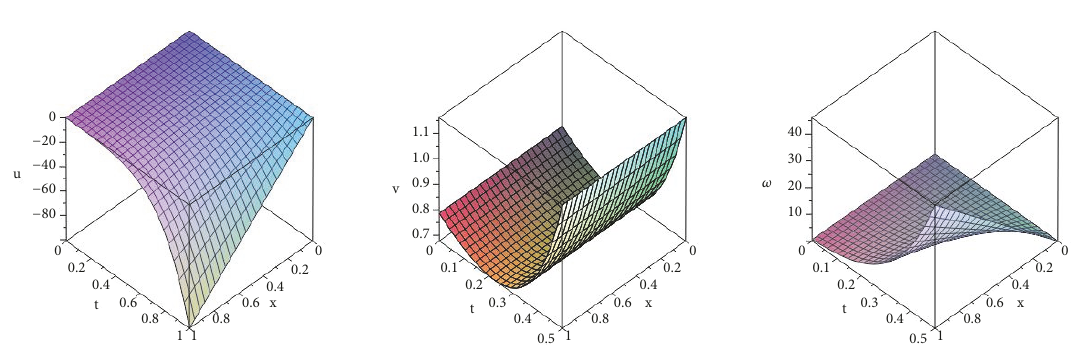
Figure 16: Surface of 𝑢 , V , and 𝜔 for 𝑀 = 1 , 𝑆 = 5 , 𝛾 = 0.5 , 𝑦 = 1 , 𝛼 = 6 , 𝑙 = 2 .